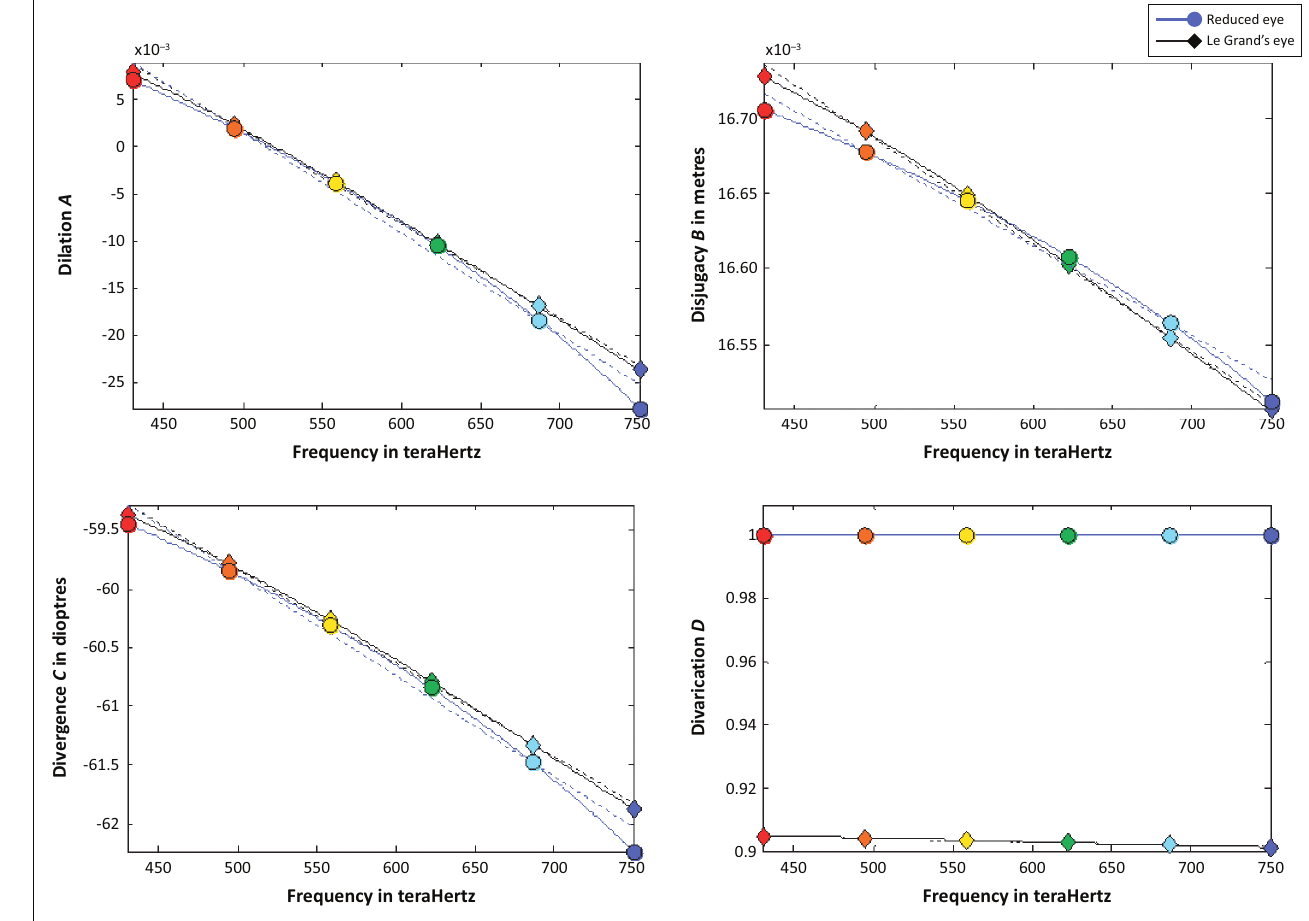
FIGURE 1: The fundamental properties of the reduced and Le Grand’s eyes as functions of frequency. The least-squares straight lines (Equation 3) are shown with dashed lines. The coloured markers represent equal spacing of 64 THz (x10 12 s − 1 ) and approximate the colours represented at each